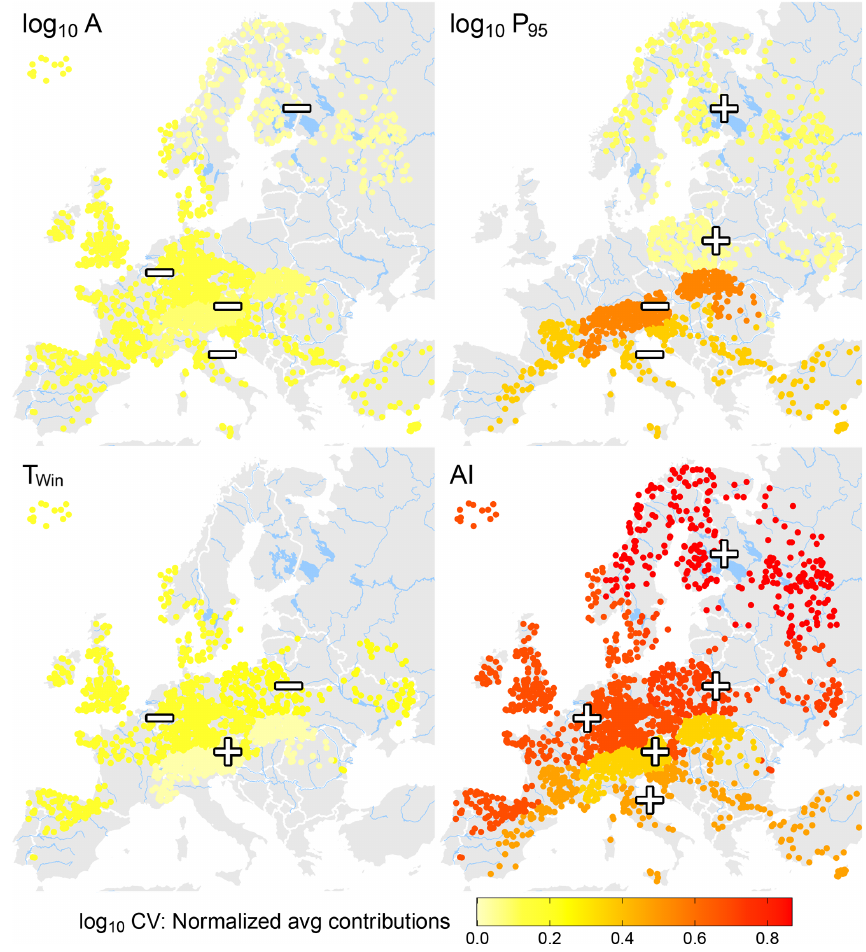
Figure 8. Results of dominance analysis for regional regression models for CV. Panels depict the average contributions (nGDM) of the covariates included in the regressions (log of catchment area, log of extreme precipitation index P 95 , mean winter temperature, and AI). Plus and minus signs indicate the sign of the regression